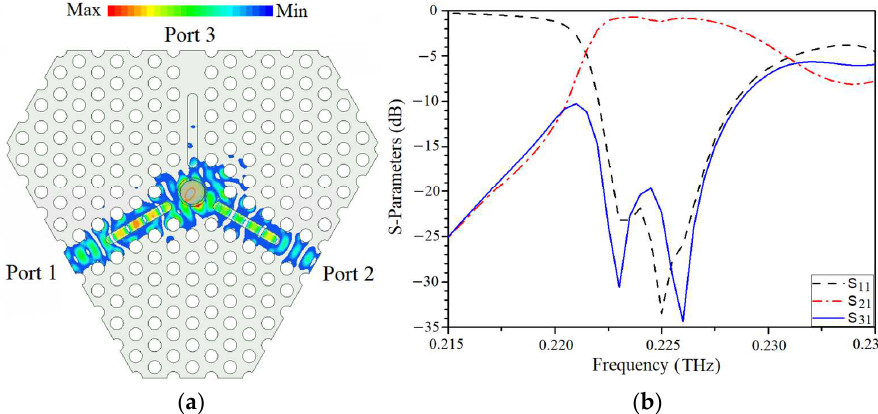
Figure 4. The transmission characteristics of the THz wave Y-shaped MPC circulator. ( a ) The electric field distribution of the circulator under center frequency. ( b )The S-parameters of the designed MPC circulator (S 11 is the reflectance, S 21 is the insertion loss, and S 31 is the isolation).